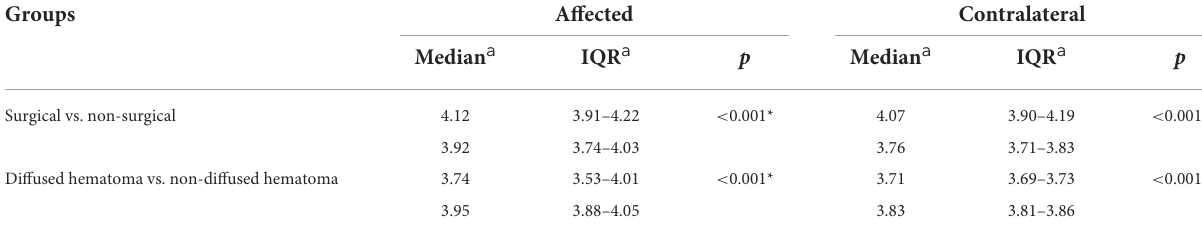
TABLE 2 Comparison of the differences in the density of gray and white matter in each subgroup (surgical n = 38, non-surgical n = 119, diffused hematoma n = 46, non-diffused hematoma n = 73). Groups Affected Contralateral